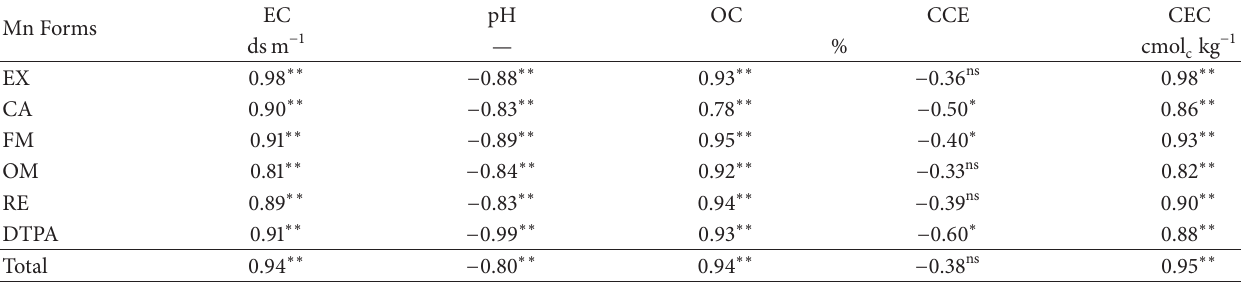
Table 5: Correlation coefficient between soil physical and chemical properties and total and available forms of Mn. EC pH OC CCE CEC Mn Forms dsm −1 EX